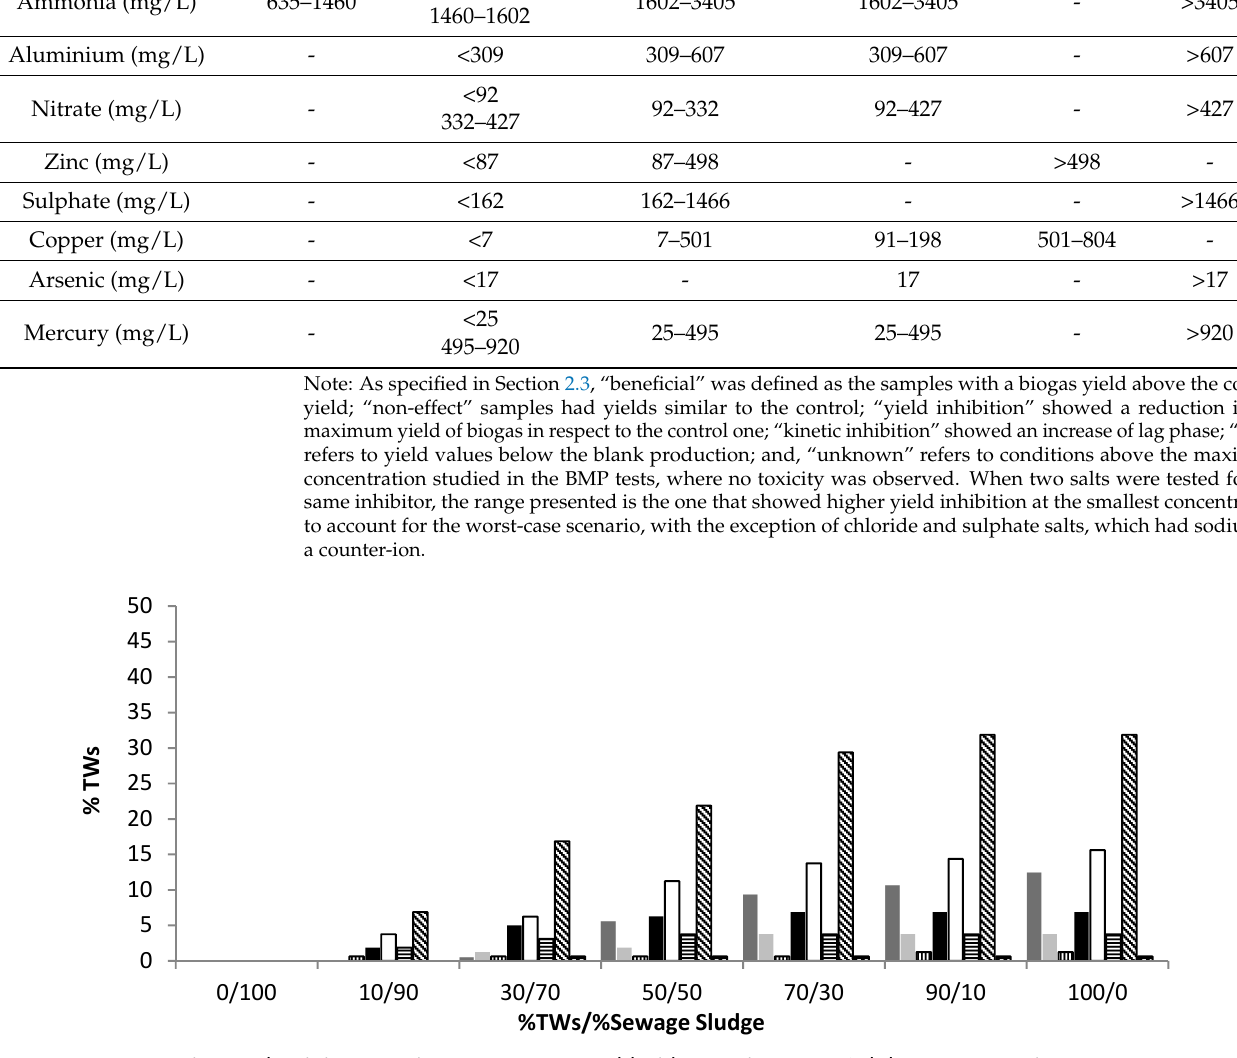
Figure 6. Percentage of TWs considered from the database (total of 160) that could result in a negative effect (inhibition or toxicity) if co-digested with sewage sludge, depending on the TWs/sewage sludge volume ratio.